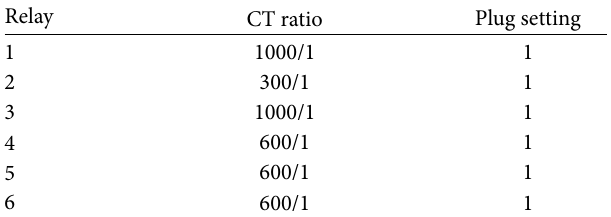
Table 3: CT ratios and plug settings of the relays for Case 1.